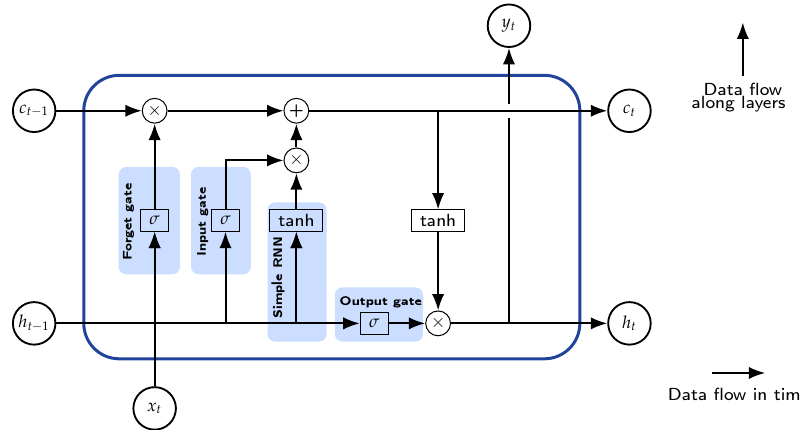
Figure 7. A long short-term memory neural network. See text for